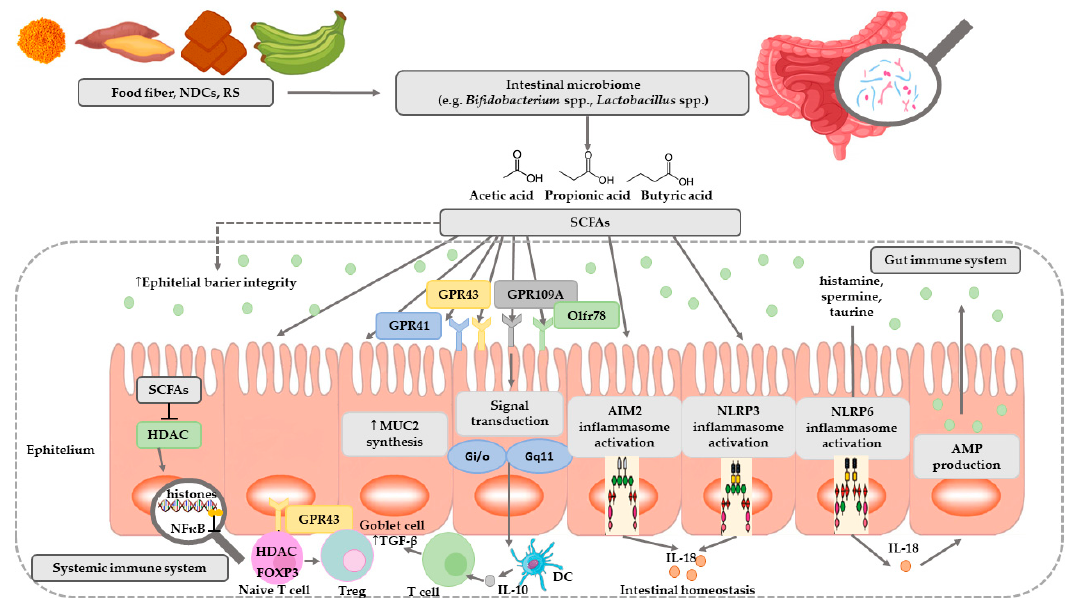
Figure 2. The role of SCFAs in regulation of intestinal homeostasis. SCFAs (acetic, propionic, and butyric acid) are produced by intestinal microbiome in fermentation of undigested food fiber, non-digestible carbohydrates (NDCs) or resistant starch (RS). SCFAs are as energy substrates for colonocytesandregulate intestinal barrier function (synthesis of mucin-MUC2) and immune system through G-protein-coupled receptors (GPR41, GPR43, GPR109A) and Olfr78 receptor signaling. SCFAs regulate the